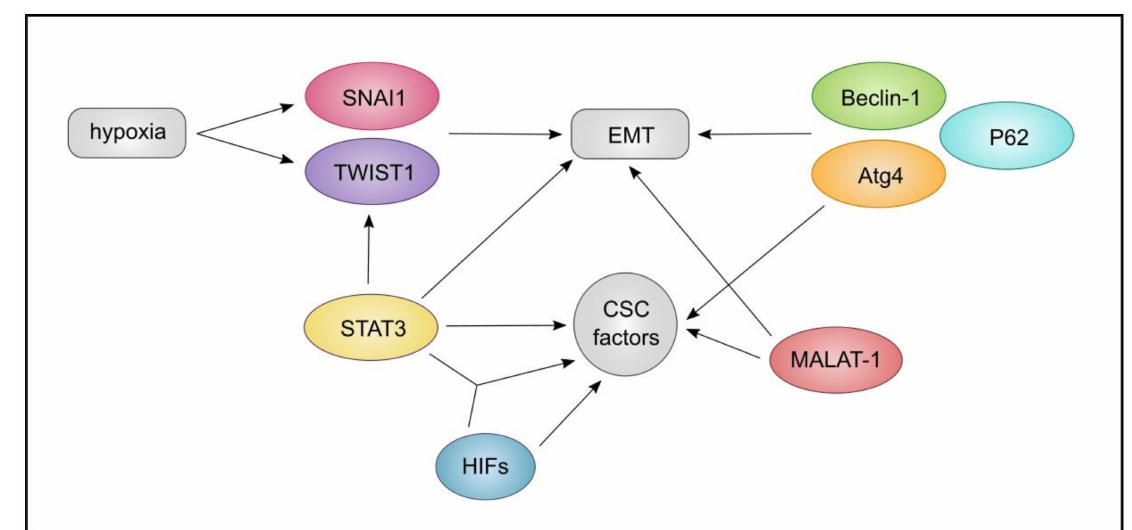
Figure 8. The interlinkage between the triangle of CSCs, lncRNAs, and autophagy with respect to epithelial-to-mesenchymal transition (EMT). Hypoxia in the TME can trigger SNAI1 and TWIST1 and relevant signalling pathways. STAT3 activation can contribute to EMT, while it can activate TWIST1 . Further, STAT3 and HIFs directly or in combination can contribute to CSC factors. LncRNA MALAT-1 can promote EMT and CSC factors. Autophagy mediators such as Beclin-1, P62, and Atg4 can contribute to both EMT and CSC